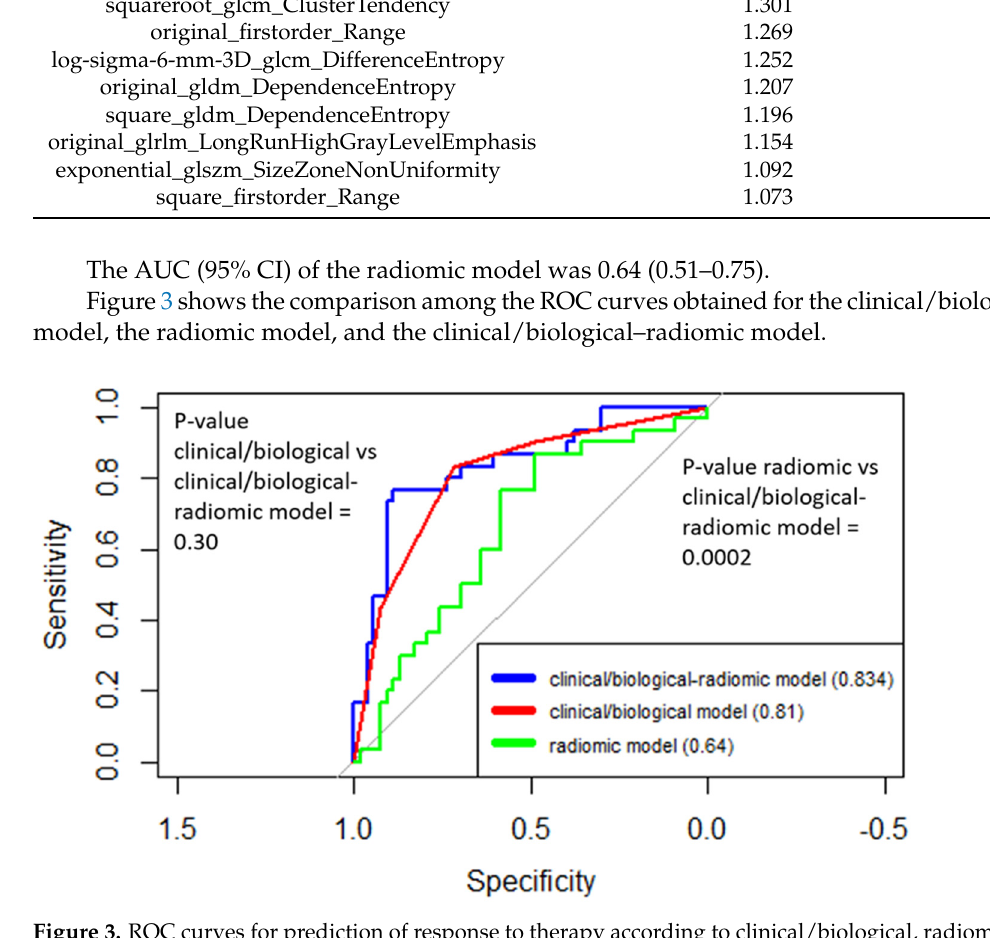
Figure 3. ROC curves for prediction of response to therapy according to clinical/biological, radiomic, and clinical/biological–radiomic models. The clinical/biological model included molecular subtype as an independent variable.